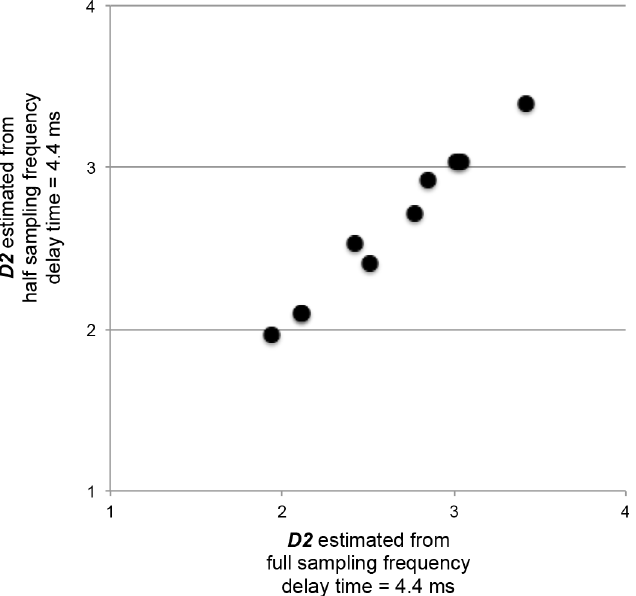
Fig 3. Scatterplot of D 2 estimated from VEPs from full and halved sampling frequencies for the same delay times of 4.4